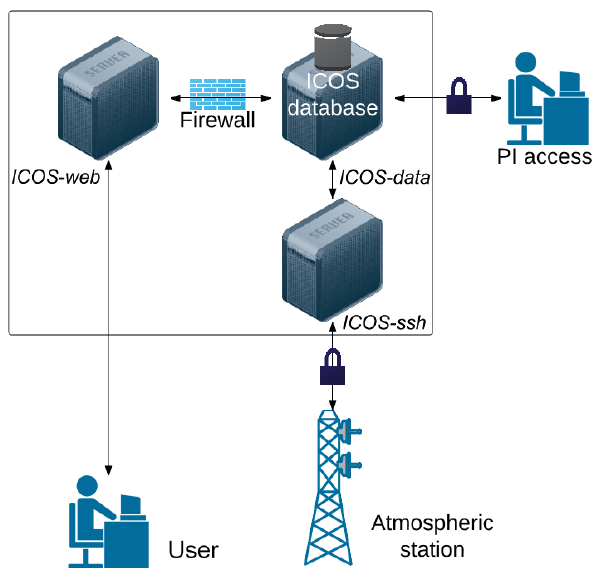
Figure 1. Schematic view of ICOS ATC network